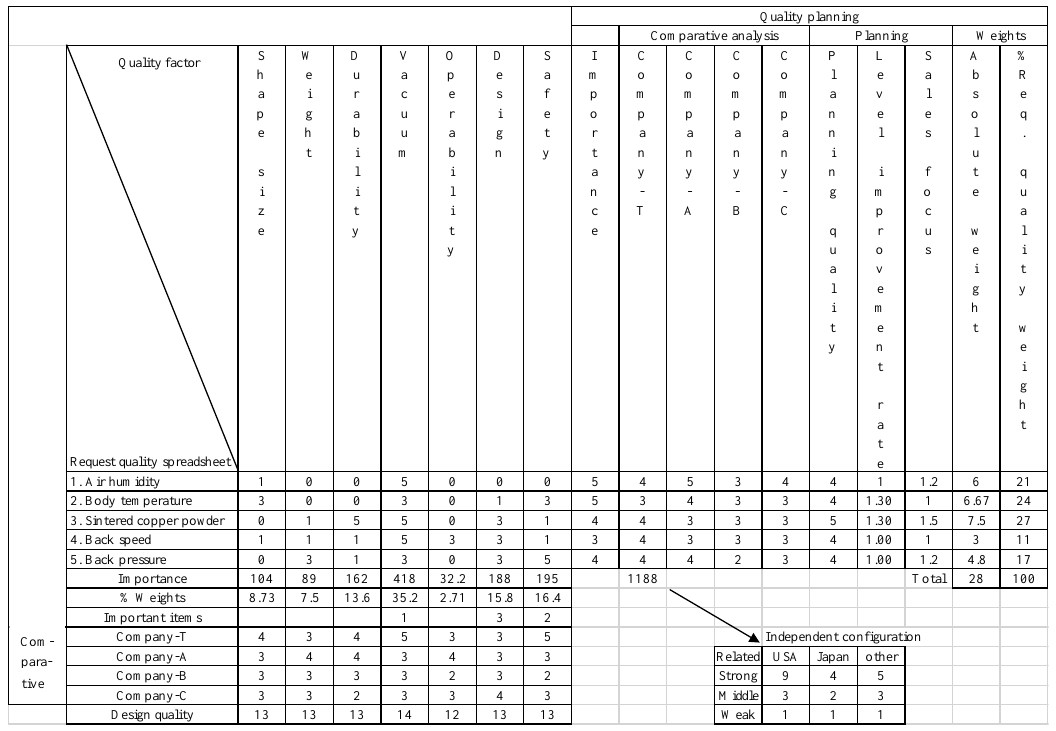
Figure 6. House of quality matrix.